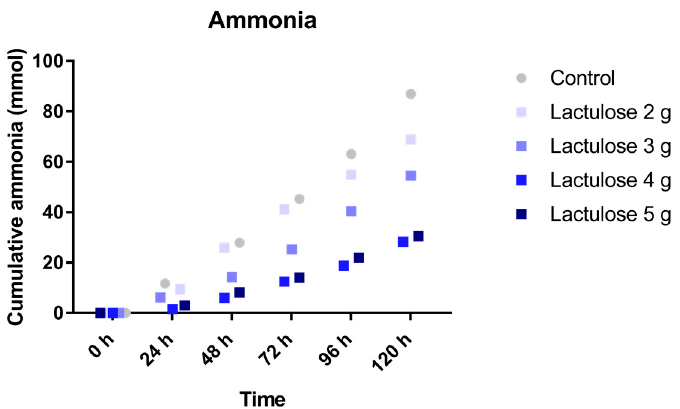
Figure 5. Cumulative ammonia production over time during the 120 h test period in TIM-2 runs (mean of n = 2 (Lactulose dosages) or n = 4 (control)). All data points shown at the proximity of the individual time points indicated at the X -axis belong to these specific time points.